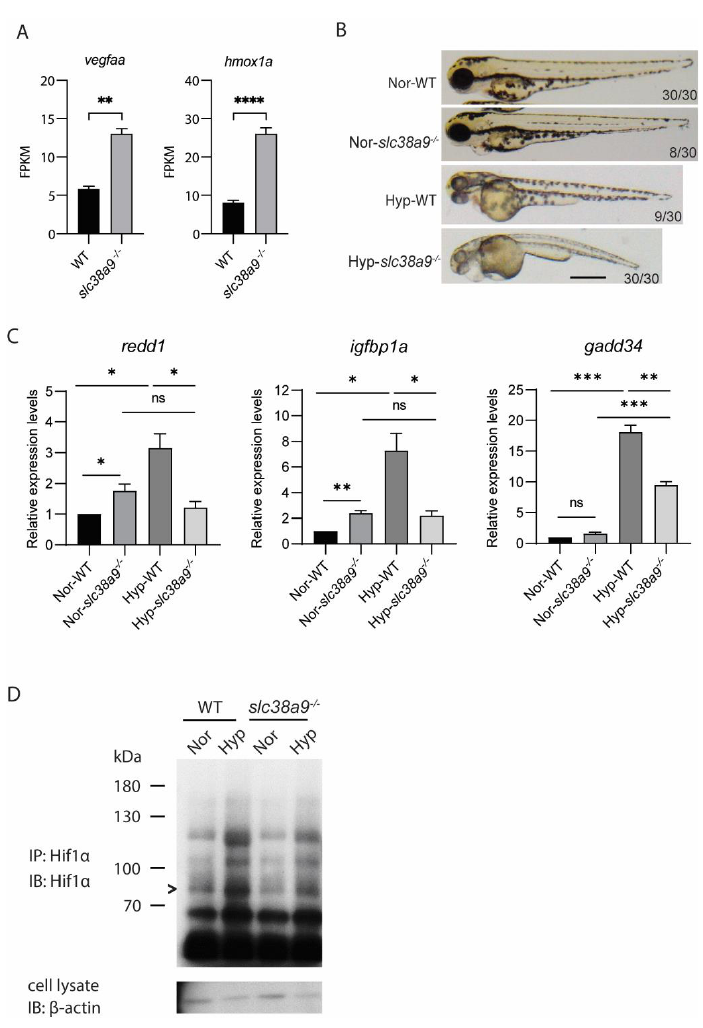
Figure 7. Slc38a9 deficiency leads to dysregulated hypoxia response. ( A ) The FPKM of hypoxia-induced genes in WT and slc38a9 mutant zebrafish embryos (60 hpf). ( B ) The phenotypic penetrance of the slc38a9 mutant increased under hypoxia treatment. Zebrafish larvae (24 hpf) were treated with hypoxia embryo rearing solution (DO = 1 mg/L) for 10 h. Normoxia (Nor) and hypoxia (Hyp). ( C ) The hypoxia-induced increase of Hif1 α target genes was blocked in the slc38a9 mutant zebrafish. The experimental groups were the same as described in ( B ). The expression of Hif1 α target genes was detected by qRT-qPCR and normalized by the β -actin mRNA levels. The mRNA levels of Hif1 α target genes were upregulated in WT zebrafish larvae under hypoxic conditions, while this increase was completely blocked in the slc38a9 mutant. Data shown are mean ± SEM, n = 3. * p < 0.05, ** p < 0.01, *** p < 0.005, **** p < 0.001. ( D ) The increase of Hif1 α protein level was attenuated in slc38a9 mutants under hypoxic conditions. The experimental groups were the same as described in ( B ). The immunoprecipitation was used to enrich the Hif1 α protein. The representative result is shown in ( D ). > Hif1 α